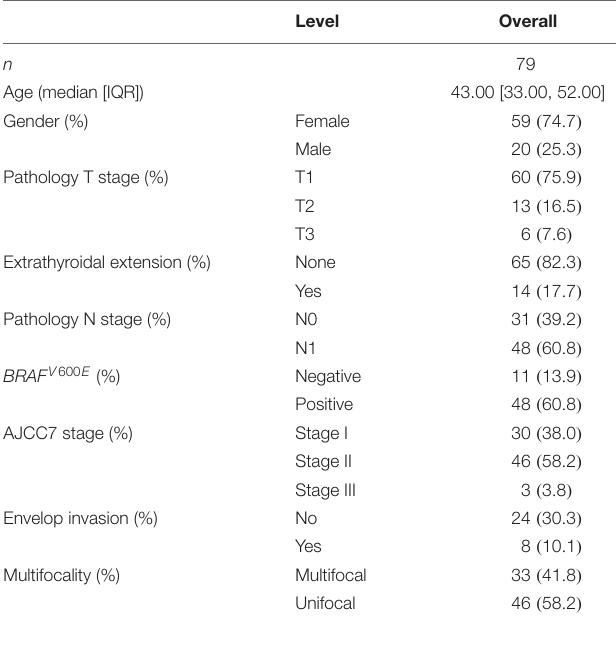
TABLE 2 | Baseline of patients in the WMU-THCA cohort.